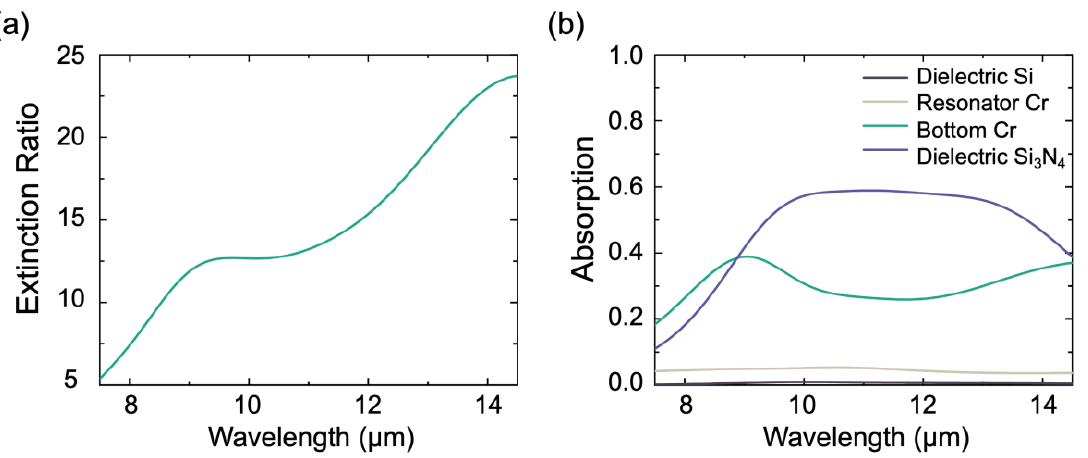
Figure 7. ( a ) Polarization extinction ratio of designed absorber; ( b ) absorbed energy distribution within each component of absorber structures.